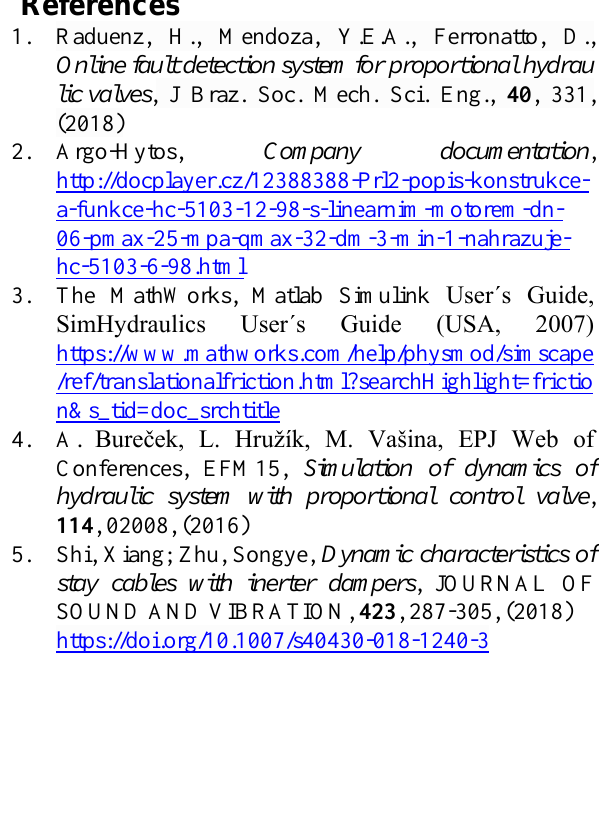
Fig. 8. Comparison of transient